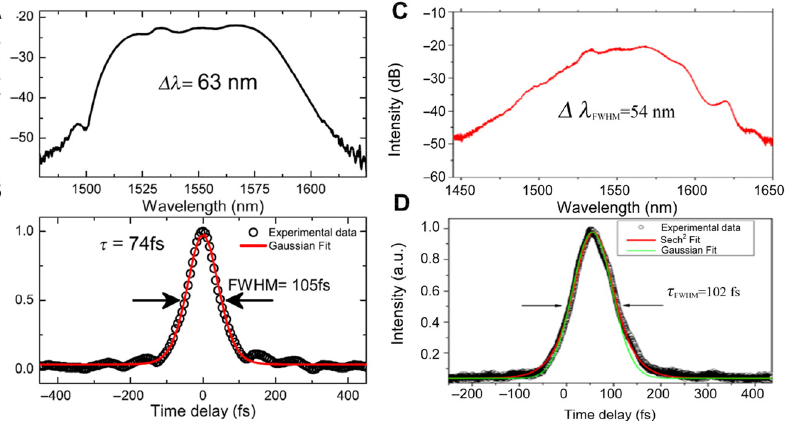
Figure 5: Laser output of the StPs at ∼ 1.55 μ m from the CNT-SA mode-locked fi ber laser: (A) – (B) Laser output with spectralwidthof63nmandpulseduration of 74 fs, Popa et al. [135]. © American Institute of Physics 2012; (C) – (D) Laser output with spectral width of 54 nm and pulse duration of 66 fs, Yu et al. [136].